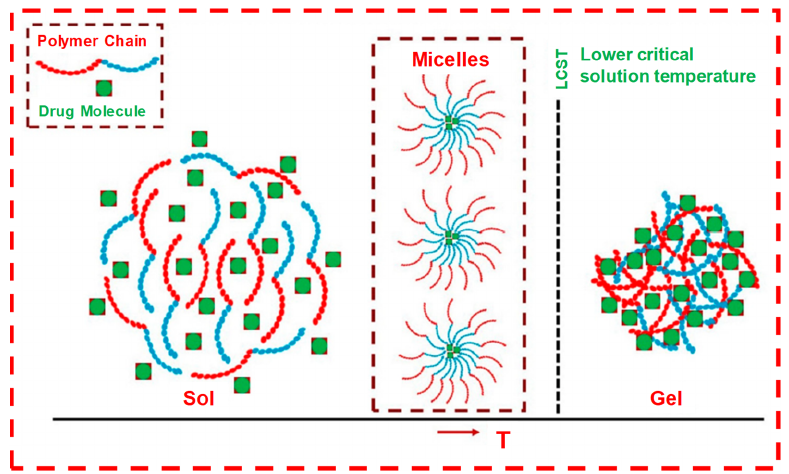
Figure 15. The sol–gel transition of LCST-type thermo-responsive polymer-based drug delivery system. Formulation over LCST changes to hydrogel from the solution state. LCST-type thermo-responsive polymer in solution forms micelles at low concentration, which further aggregates at high polymer concentration to form gel at a temperature ≥ LCST. Adapted with permission from ref. [5]. Copyright © 2021 Polymer MDPI.